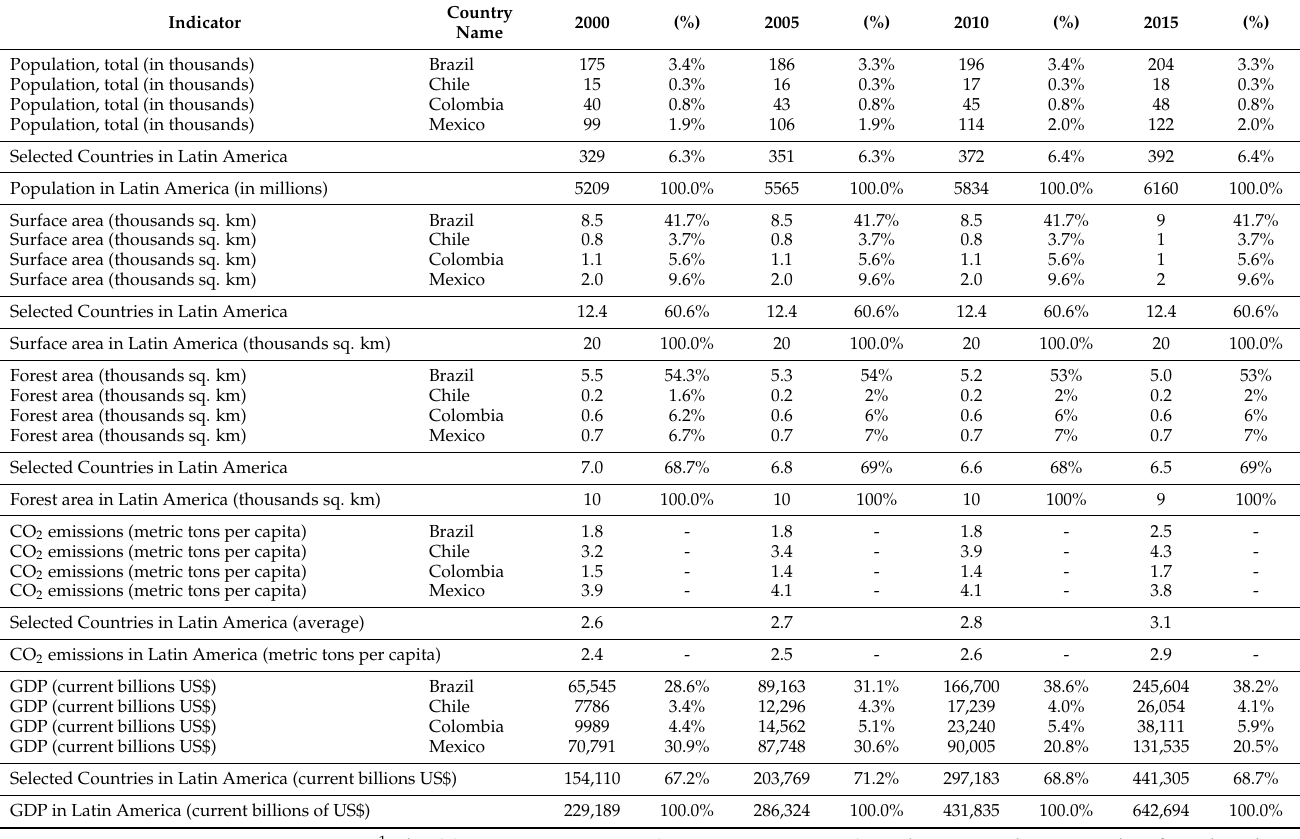
Table 1. Socioenvironmental indicators for selected LA countries 1